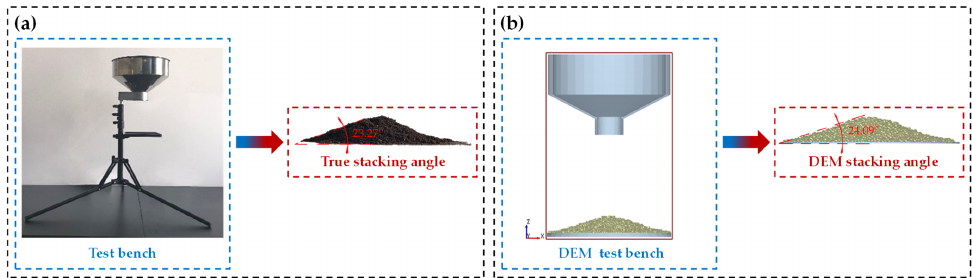
Figure 3. Measurement process and equipment of black soil stacking angle parameters. ( a ) Measurement process and equipment of real black soil stacking angle parameters. ( b ) Measurement process and equipment of black soil stacking angle parameters in DEM virtual simulation tests.